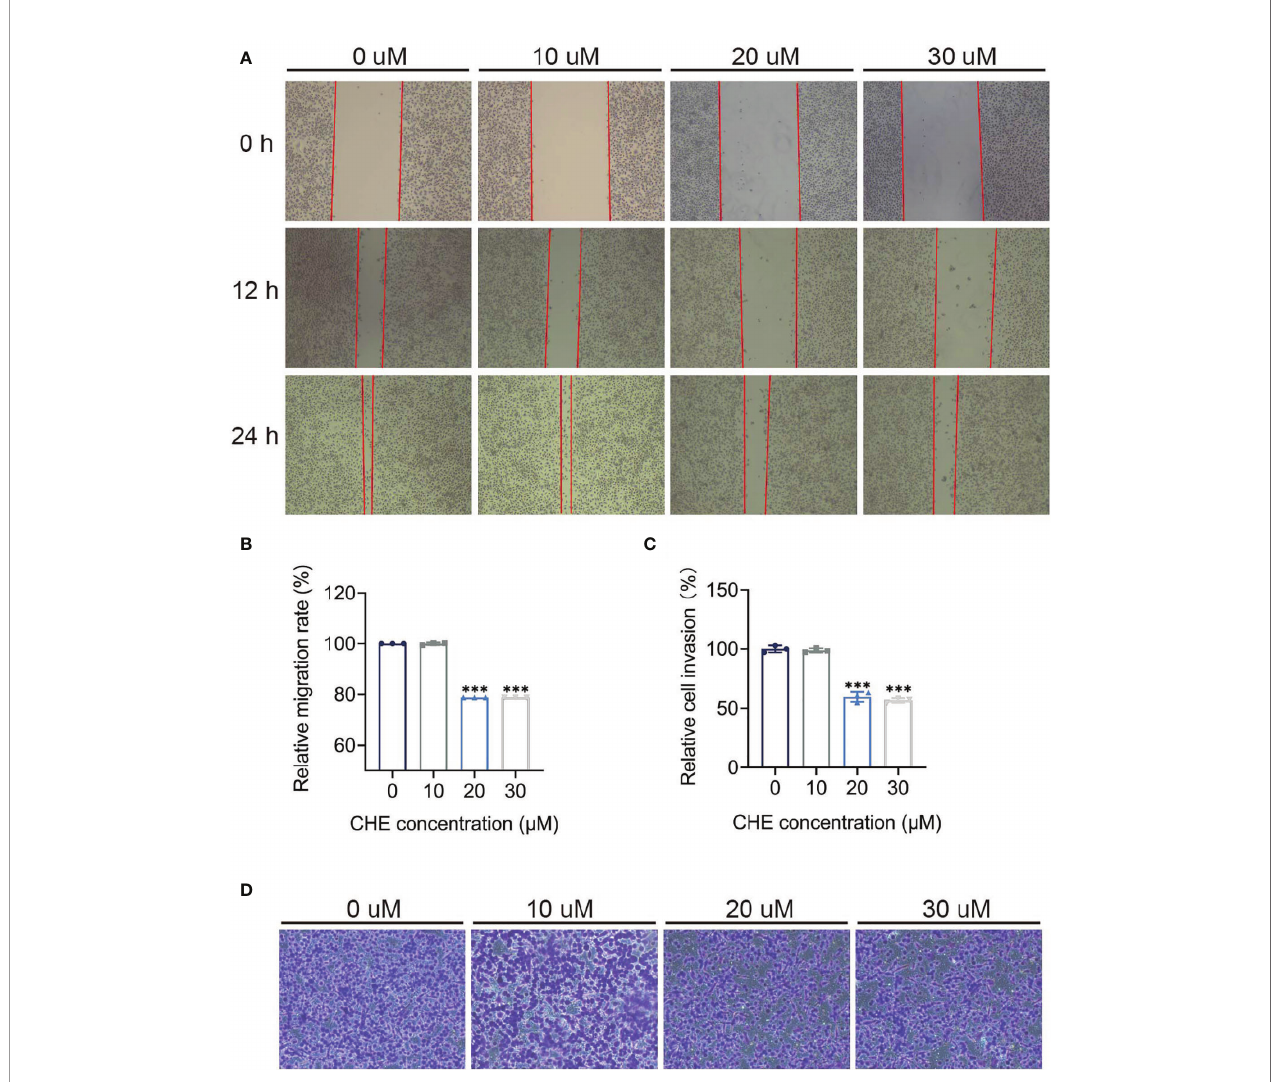
FIGURE 3 | CHE impeded the migration and invasion of HCC827 cells. (A, B) The wound-healing assays of HCC927 cells after treatment with CHE. (C, D) The trans-well migration assays. (***p <